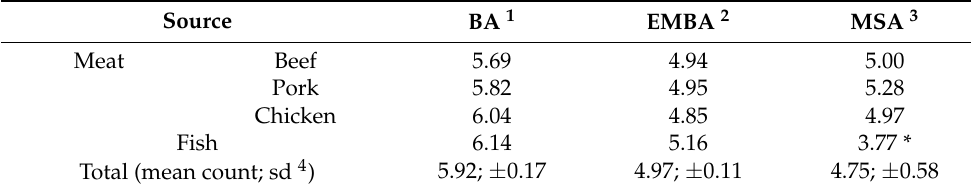
Table 1. Mean Bacterial viable counts (log10 CFU/g) in meat and beef samples considering different selective culture for Gram-positive and Gram-negative human putative